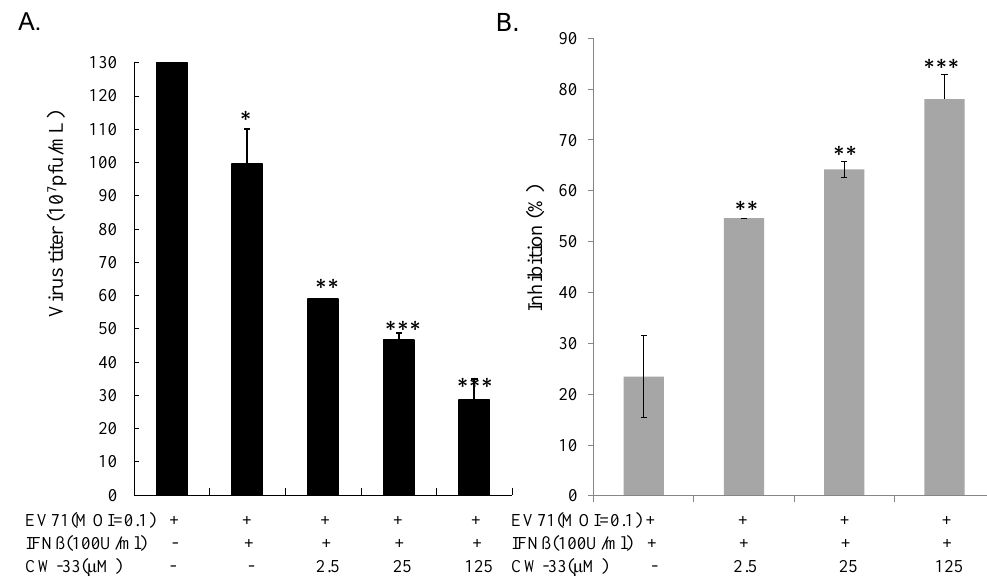
Figure 6. Inhibition of supernatant EV-A71 yield by combined treatment of CW-33 and IFN- β . Cells infected with EV-A71 were immediately treated with CW-33 alone or in combination with IFN- β . Supernatant was harvested 48 h post-infection, virus yield measured by plaque assay ( A ), inhibitory ratio calculated from ratio of experimental data to mock control ( B ). * p value < 0.05; ** p value < 0.01; *** p value < 0.001 by Scheffe test.